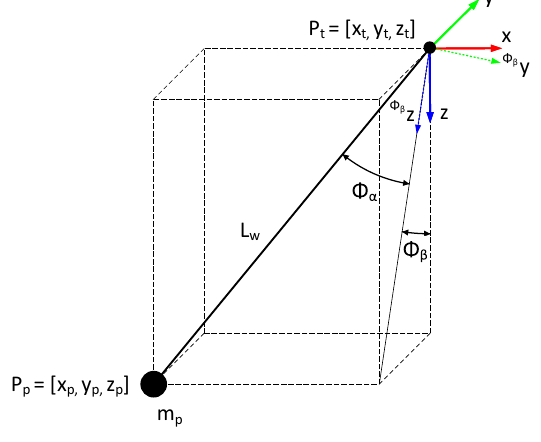
Figure 16: Illustration of a 3D suspend load repre- sented by